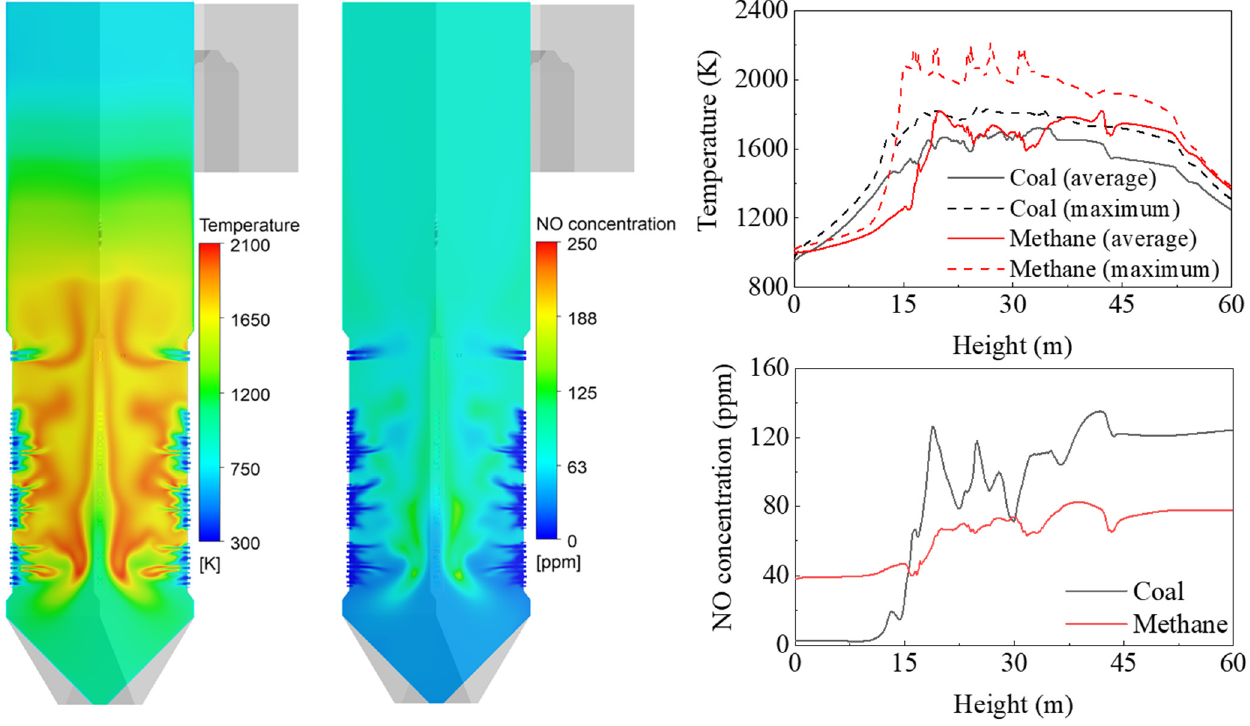
Figure 6. Contours and profiles of gas temperature and NOx mole fraction during gas